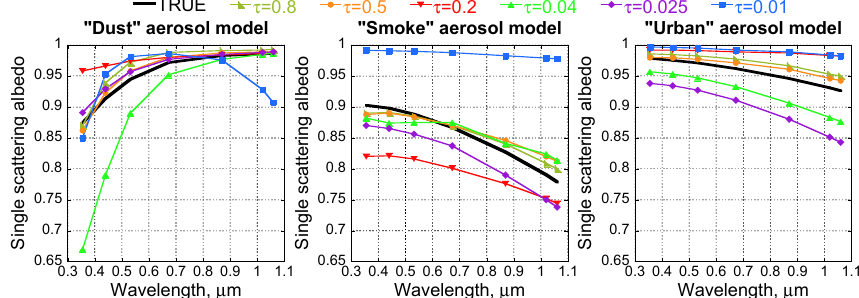
Fig. 8. Retrievals of the single-scattering albedo of aerosol components under different AOT.